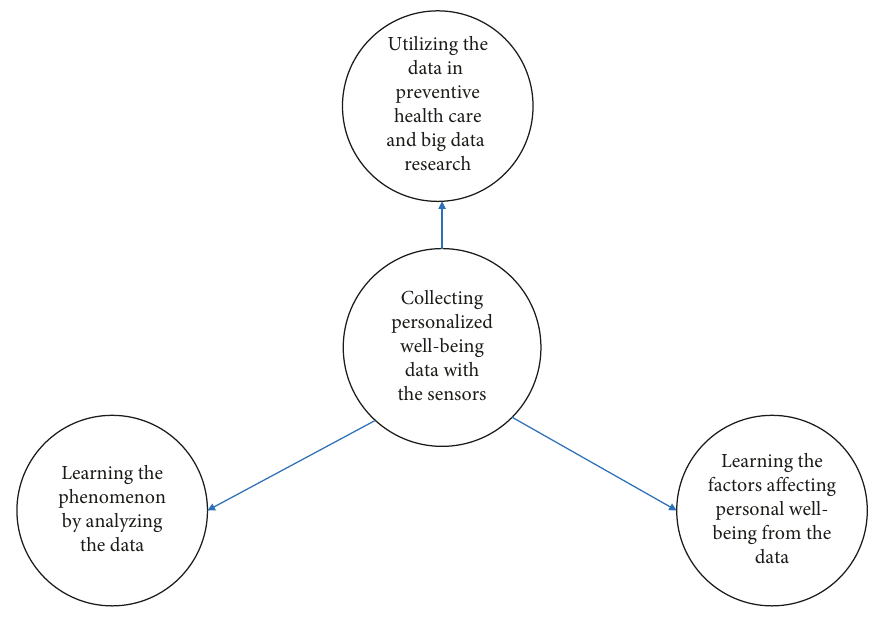
Figure 1: Use of collected data in sensor-based